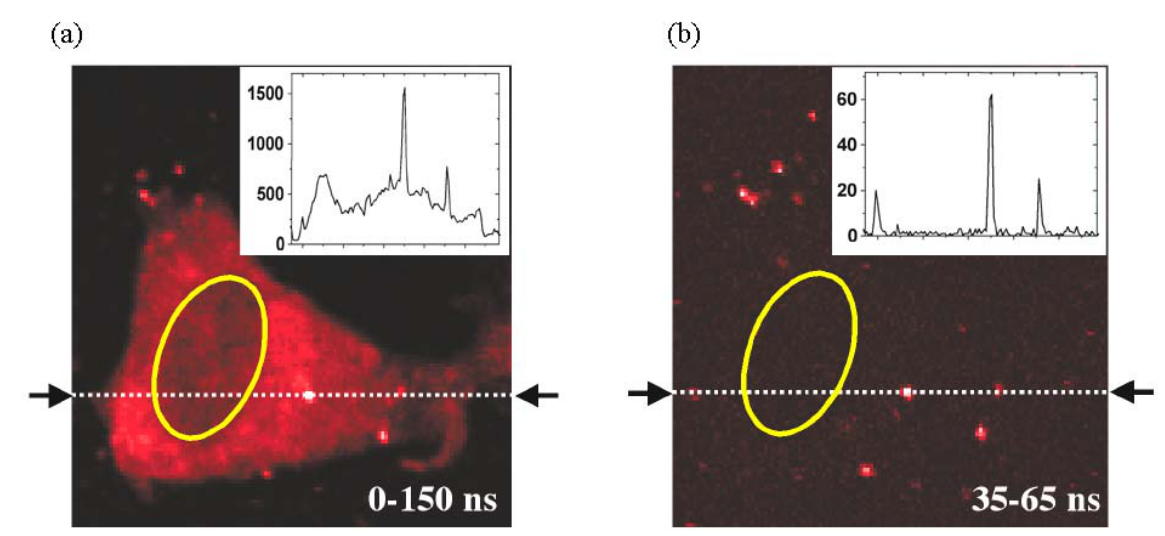
Figure 23. Time-resolved confocal optical micrography of 3T3 cell. (a) A micrograph acquired from all the detected photons; (b) Time-gated micrograph constructed from only photons that arrived 35–65 ns after the laser pulse (laser intensity: 0.1 kW.cm-2; integration time per pixel: 25 ms. Inset figures show cross-sections along the same horizontal line (indicated by the black arrows) for (a) and (b) [360] (Copyright Optical Society of